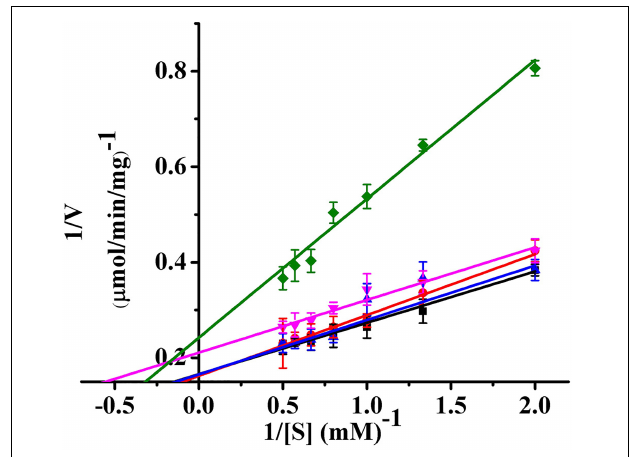
FIGURE 9 | Lineweaver–Burk double reciprocal plots of Ps-Grx3 with respect to DHA ( (cid:4) ), S-sulfocysteine ( ), HED ( (cid:78) ), L -cystine ( (cid:72) ) and BSA ( (cid:7) ). Enzyme activity was measured as described above. All the experiments were (cid:32) performed in triplicate.